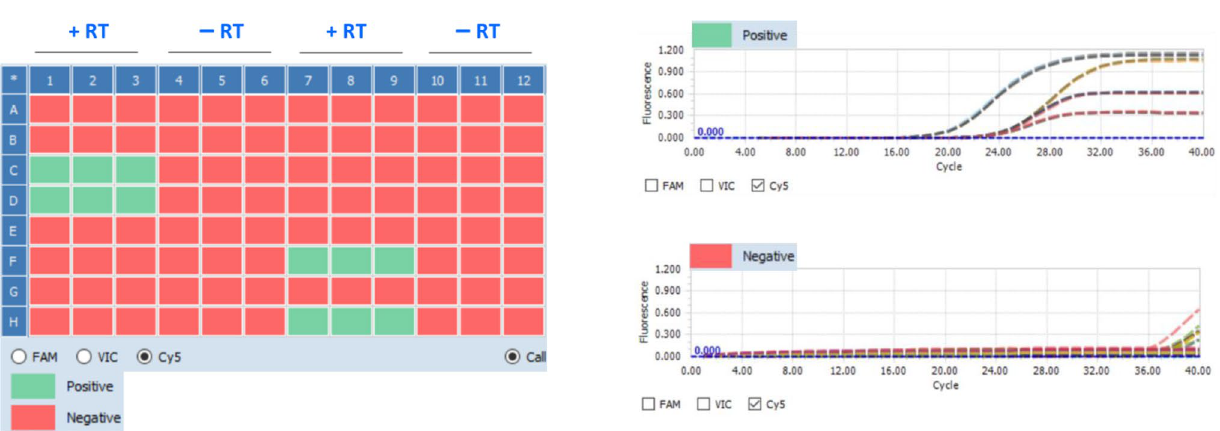
Figure 5. 16S rRNA qRTPCR results for month two post-initiation of therapy sputa from the DS and DR cohorts performed with and without reverse transcriptase (RT) confirms RNA-specific amplification. qRTPCR results for sixteen sputa samples amplified with primer set 16S rRNA F1 R1 (0.1 µM), each performed in triplicate, are presented. Lack of amplification when reverse transcriptase (RT) is left out of the reaction (left panel) confirms lack of Mtb DNA contamination. Amplification curves for positive and negative samples are shown on the right. For completeness, amplification curves for all negative samples (both with and without reverse transcriptase) are shown (bottom right panel). Each group of three boxes (such as C1–C3) represents one sputum sample performed in triplicate either with (+ RT) or without RT (−